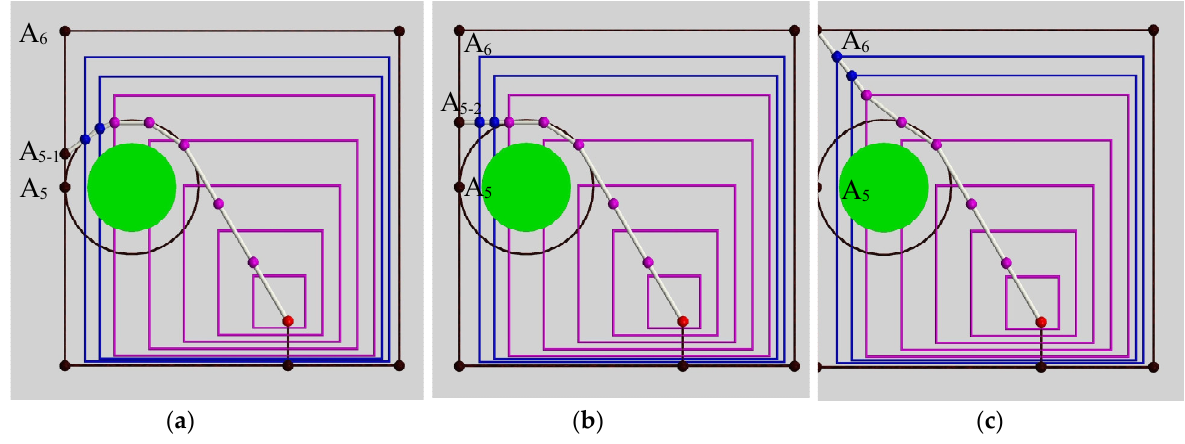
Figure 9. Two-dimensional projection diagrams of the process of the manipulator when the end- effector moves from A 5 to A 6 . ( a ) End-effector is located at A 5 - 1 ; ( b ) End-effector is located at A 5 - 2 ; ( c ) effector moves from A 5 to A 6 . ( a ) End-effector is located at A 5-1 ; ( b ) End-effector is located at A 5-2 ; ( c ) End-effector is located at A 6 . End-effector is located at A 6